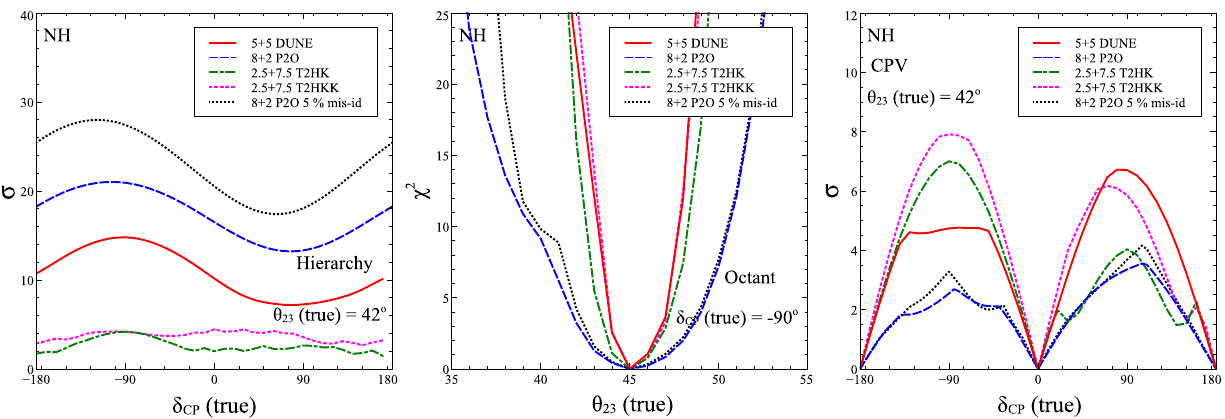
Fig. 13 Comparison of the expected sensitivity of P2O, DUNE, T2HK and T2HKK to discover neutrino mass hierarchy (left panel), octant of θ 23 (middle panel) and CPV (right panel). For hierarchy and CPV sensitivity the true value of θ 23 is 42 ◦ and for octant sensitivity the true value of δ CP is − 90